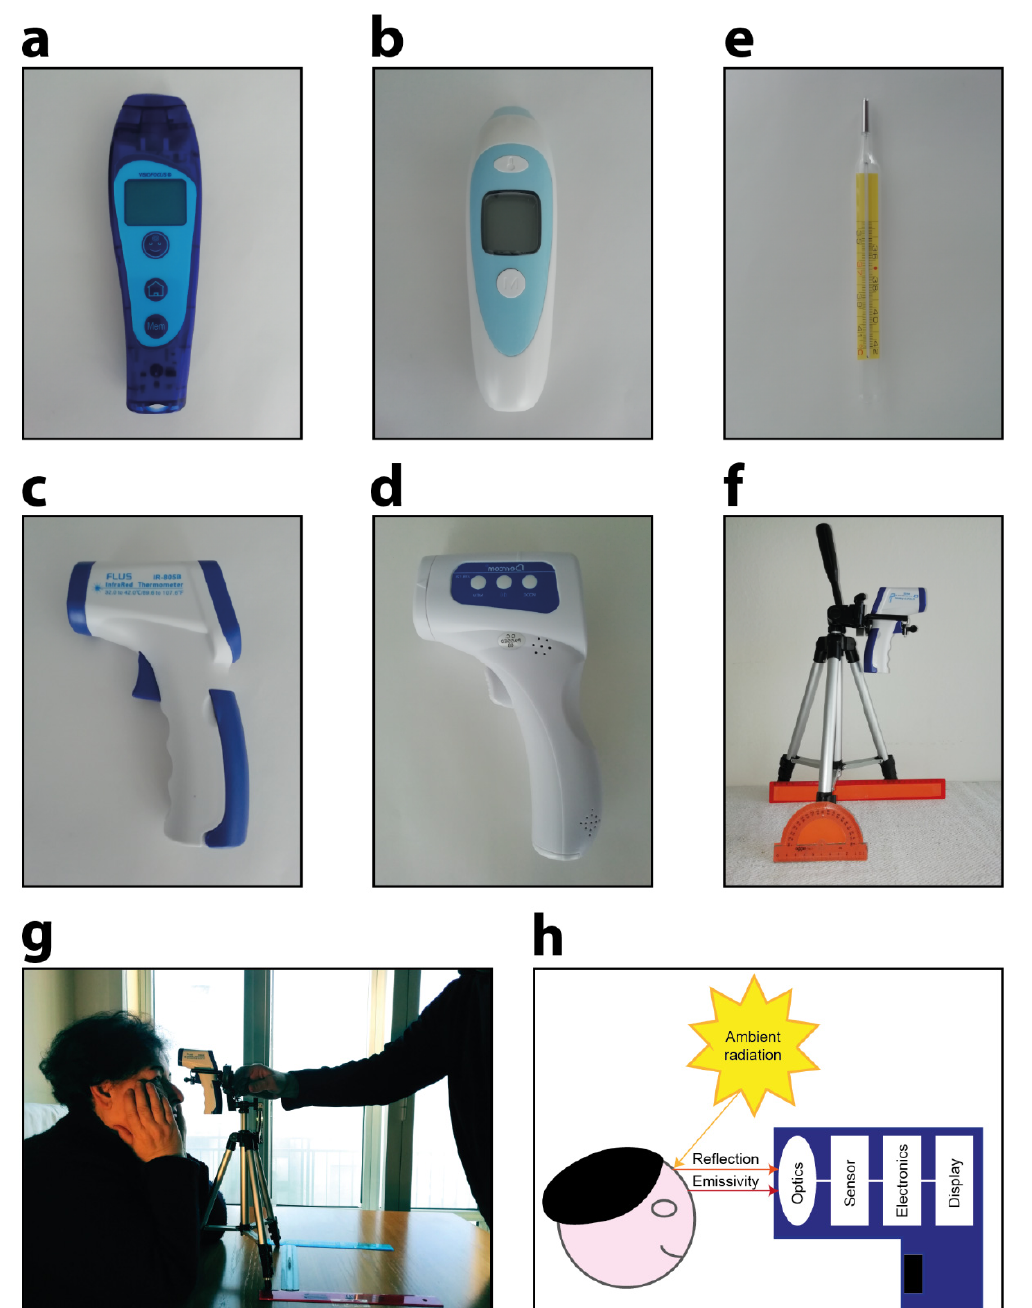
Figure 1. Contactless infrared thermometers used in this work: ( a ) TECNIMED VisioFocus PRO 06480; ( b ) Medek MDI261; ( c ) FLUS IR-805B; ( d ) Berrcom JXB-178 (T2). ( e ) Axillary mercury-based analogical thermometer. ( f ) Ruler, goniometer, and tripod used in the experiments. ( g ) Representative photograph acquired during the experiments. ( h ) Schematic representation of the detected infrared radiation composed of the emitted signal and the component of the ambient radiation reflected from the surface of the body of the person.